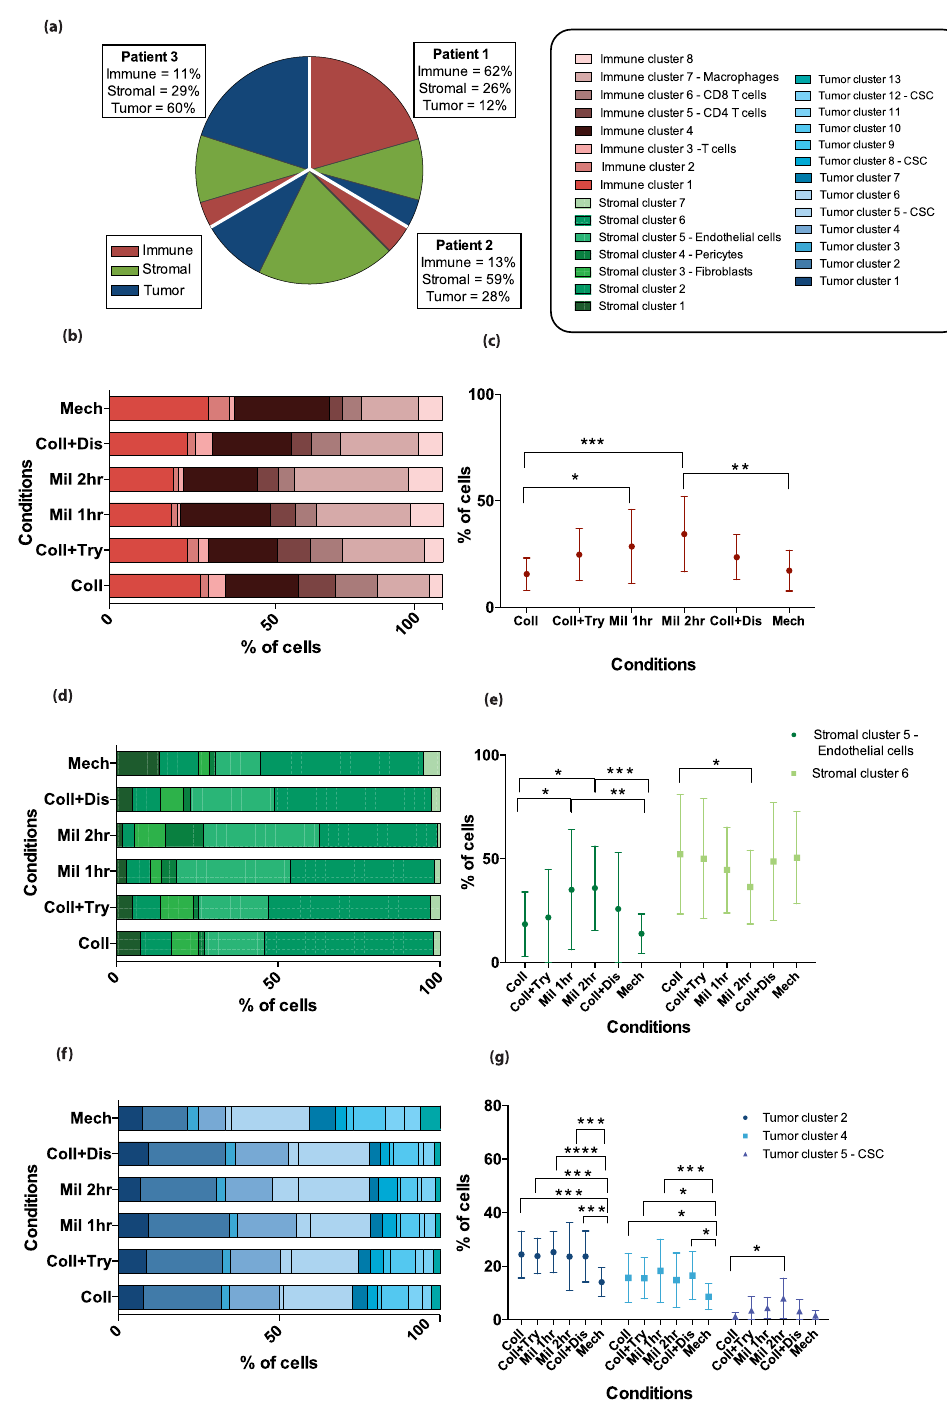
Figure 4. Differences in specific cell cluster proportions of the total cell population by dissociation method. ( a ) The pie chart displays the proportions of the three different metaclusters—immune cells in red, stromal cells in green, and tumor cells in blue—in three patients, out of a total of 300%. The graph is based on the pooled results from the six dissociation methods. The patient-specific fractions of each metacluster are shown in the text boxes. ( b , d , f ) Stacked bar plots illustrate how the identified clusters (color coded according to legend in ( a )) within the metaclusters are proportioned in the combined patient samples according to the dissociation method applied for ( b ) immune cells, ( d ) stromal cells, and ( f ) tumor cells. ( c , e , g ) Error plots displaying the mean percentage of cells in the combined data from three patient samples with standard deviations. The specific clusters included in the figure are those where significant differences between dissociation methods were found by a two-way ANOVA analysis with Tukey’s multiple comparisons test. * p -value less than or equal to 0.05. ** p -value less than or equal to 0.01. *** p -value less than or equal to 0.001. **** p -value less than or equal to